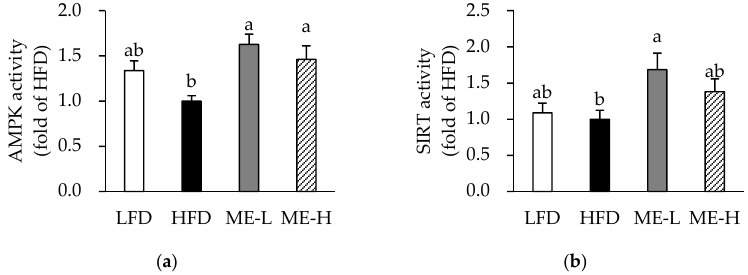
Figure 6. Effect of mulberry fruit extract on AMPK and SIRT activities in skeletal muscle. ( a ) AMPK activity. ( b ) SIRT activity. The protein activities were normalized to total protein concentration. Values are expressed as mean ± SEM (n = 8/group). Bars with different letters indicate a significant difference at p < 0.05. Abbreviations: LFD, low-fat diet; HFD, high-fat diet; ME-L, HFD + 5 g/kg diet of mulberry fruit extract; ME-H, HFD + 10 g/kg diet of mulberry fruit extract; AMPK, AMP-activated protein kinase; and SIRT,